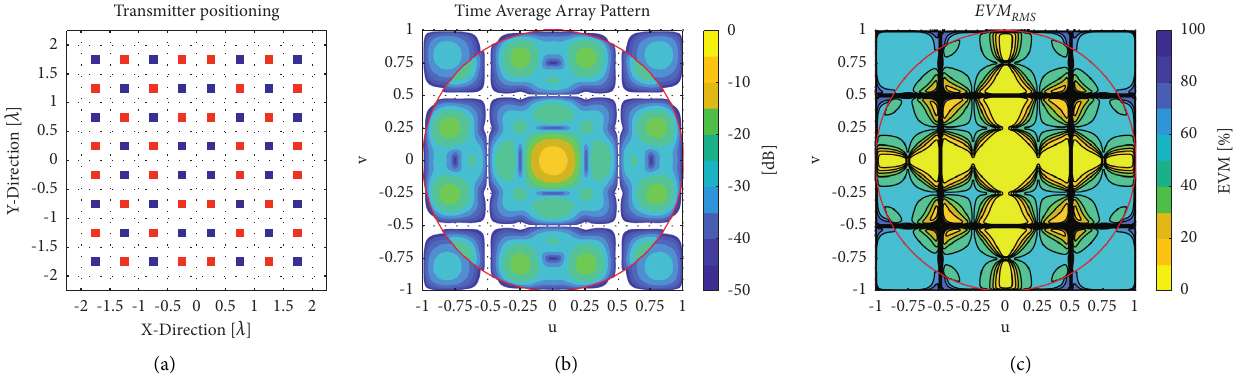
� d � ( λ /2 ) , ( C / N ) � 50 dB , transmitted signal is QAM16, and a cos θ x y 0